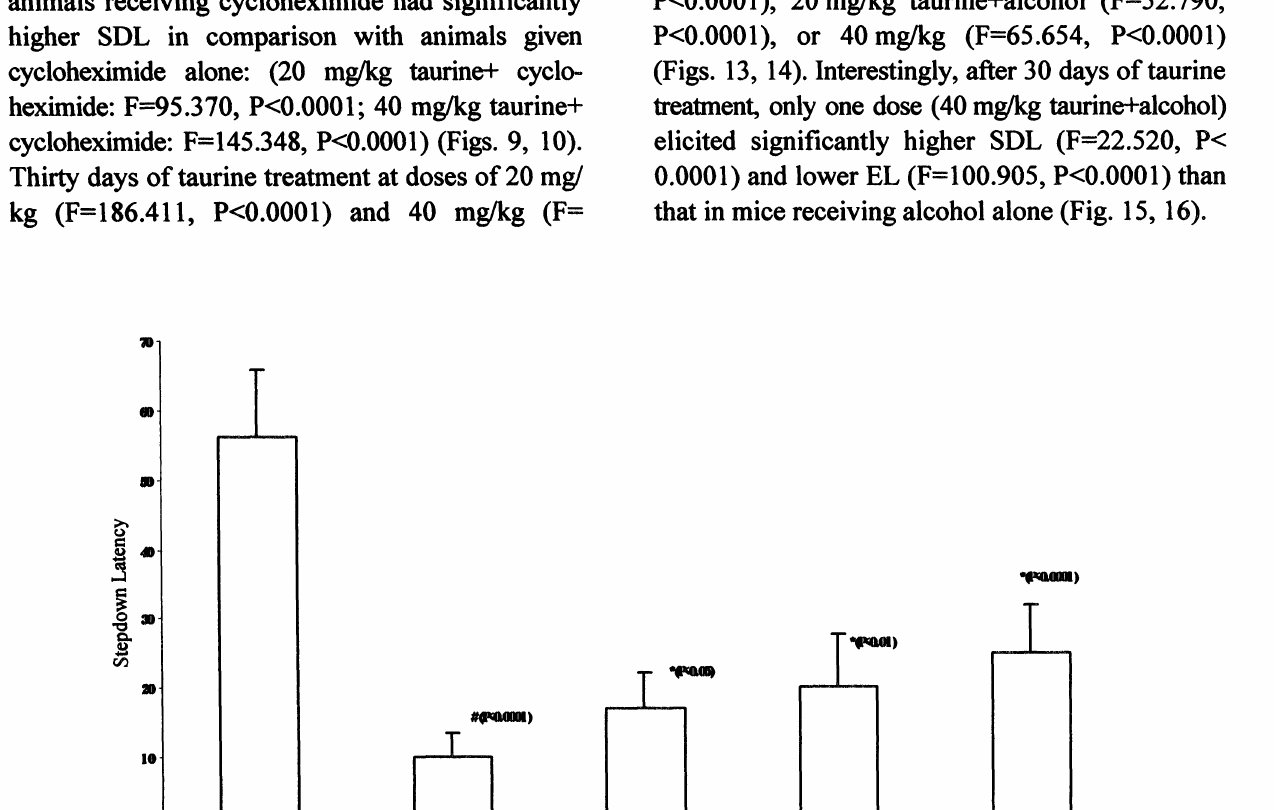
Sodium nitrite + Sodium nitrite + Sodium nitrite Control Sodium nitrite 10 mg/Kg Taurine 20 mg/Kg Taurine 40 mg/Kg Taurine # significantly different from controls. * significantly different from the sodium nitrite treated mice Effect of 10 days of taurine treatment on stepdown latency in sodium nitrite-treated Fig. 5: